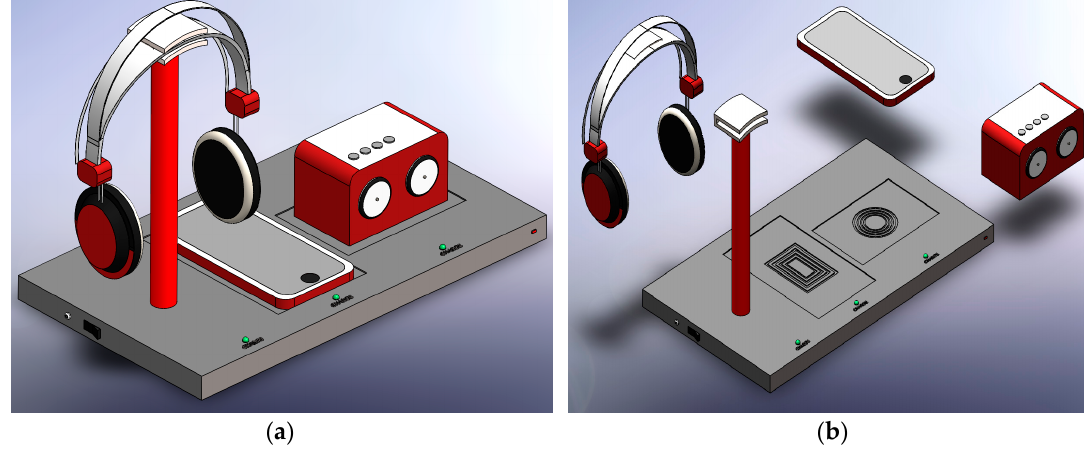
Figure 2. Conceptual design: ( a ) proposed architecture; ( b ) proposed wireless hanger and pad design. Energies 2020 , 12 , x FOR PEER REVIEW